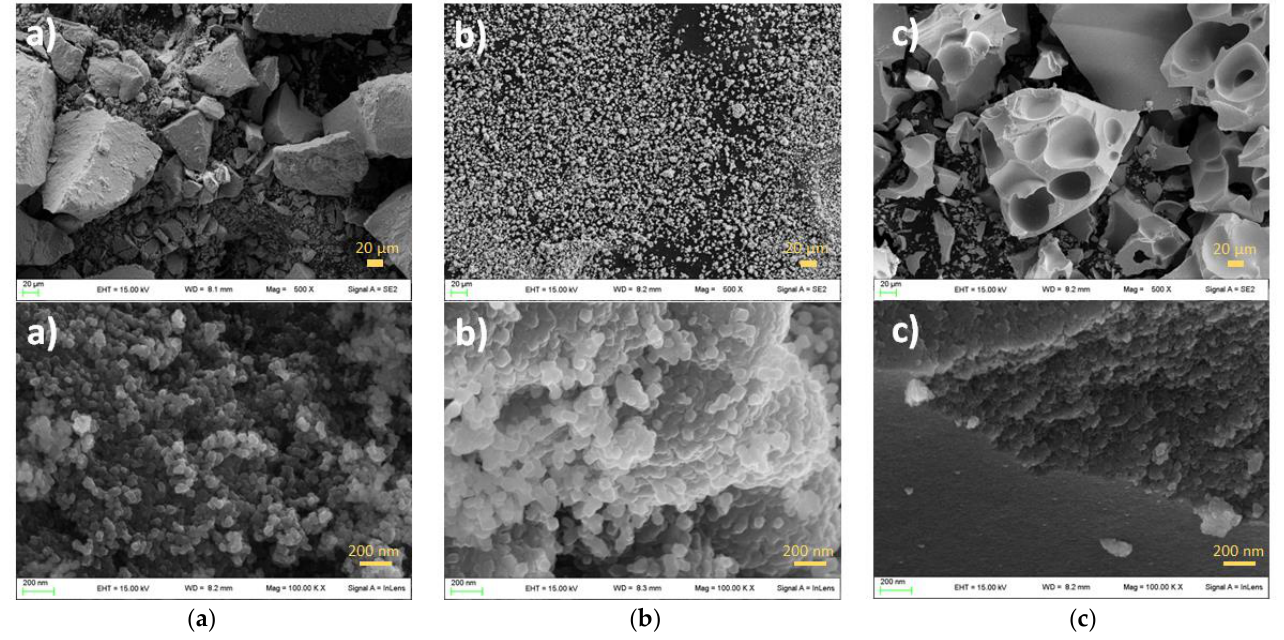
Figure 3. SEM images of the catalysts ( a ) NiCe (i); ( b ) NiCe (c); ( c ) NiCe (n). Table 2. NiO crystallite dimensions obtained by XRD analysis using the Scherrer equation; phase composition of the catalysts determined via XRD.